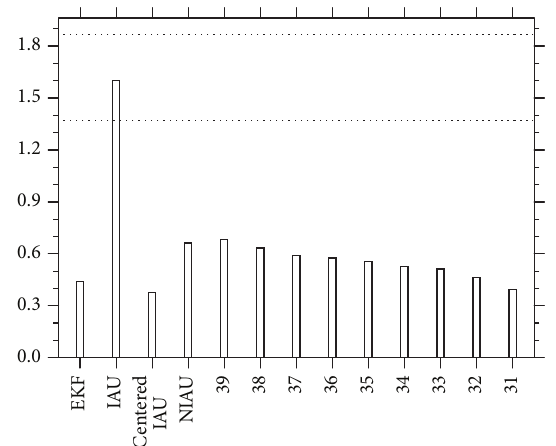
Figure 7: The time averaged (from day 0 to day 10) forecast RMS error (RMSE) initialized using the EKF, the IAU (forward), the centered IAU, theNIAU, andtheNIAU with thereconstructedTLM. Note that the initial condition is obtained after a 10-day assimilation for each case, which is the same as in the assimilation experiment. The dotted line denotes the 95% confidence level of the forecast RMSE in the IAU